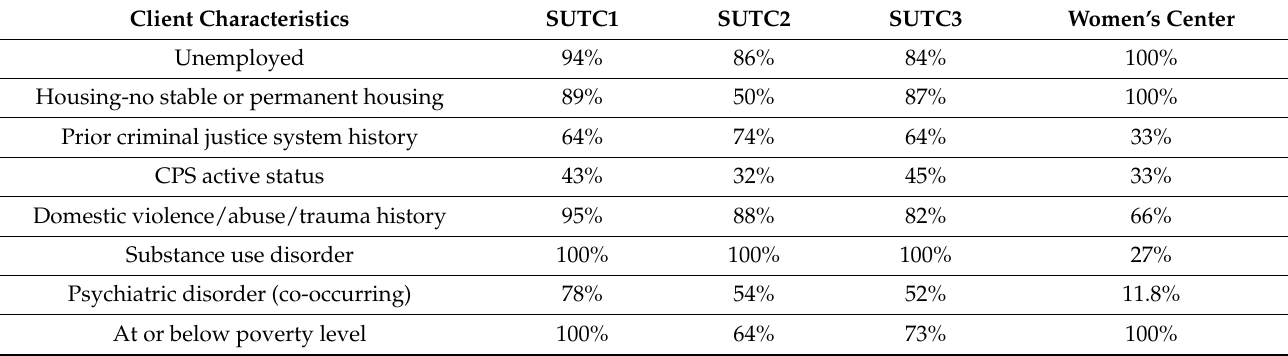
Table 2. Demographic characteristics of center